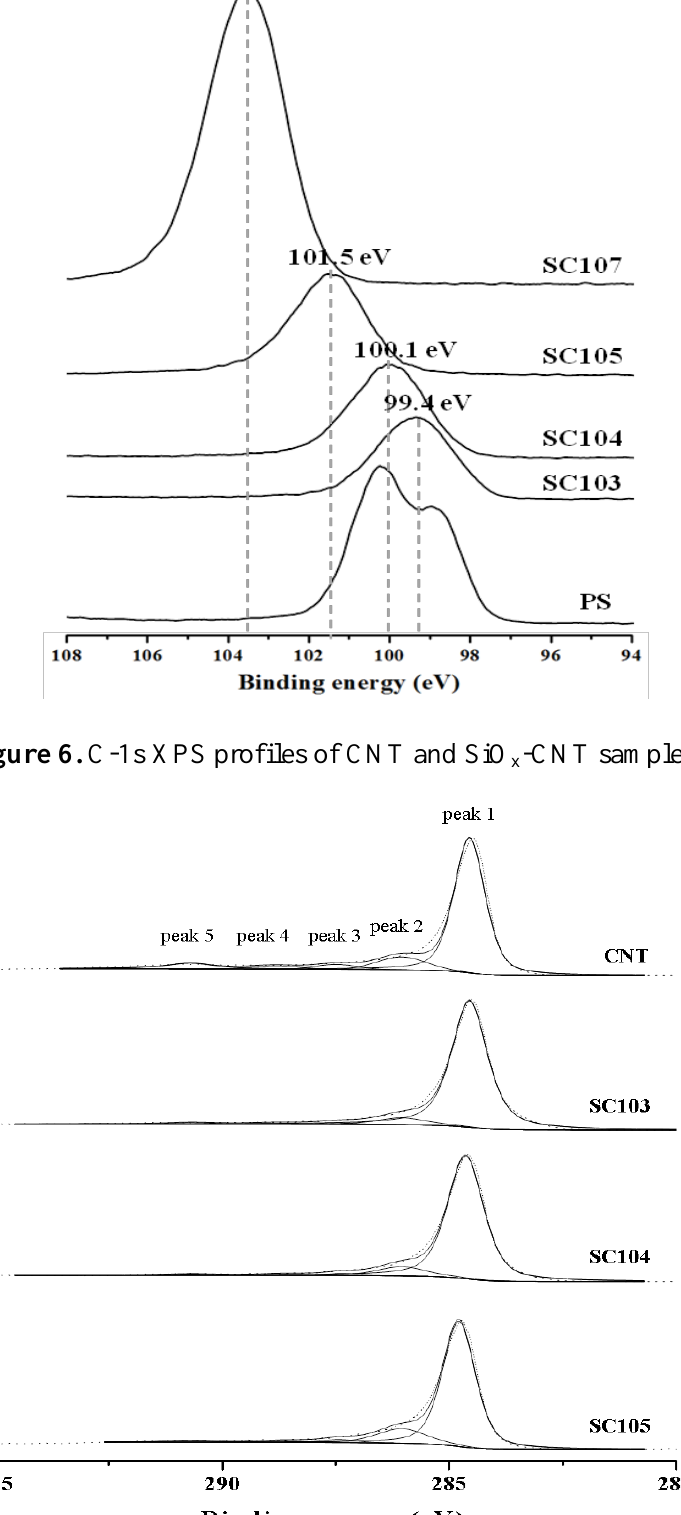
Figure 5. Si-2p XPS profiles of PS and SiO